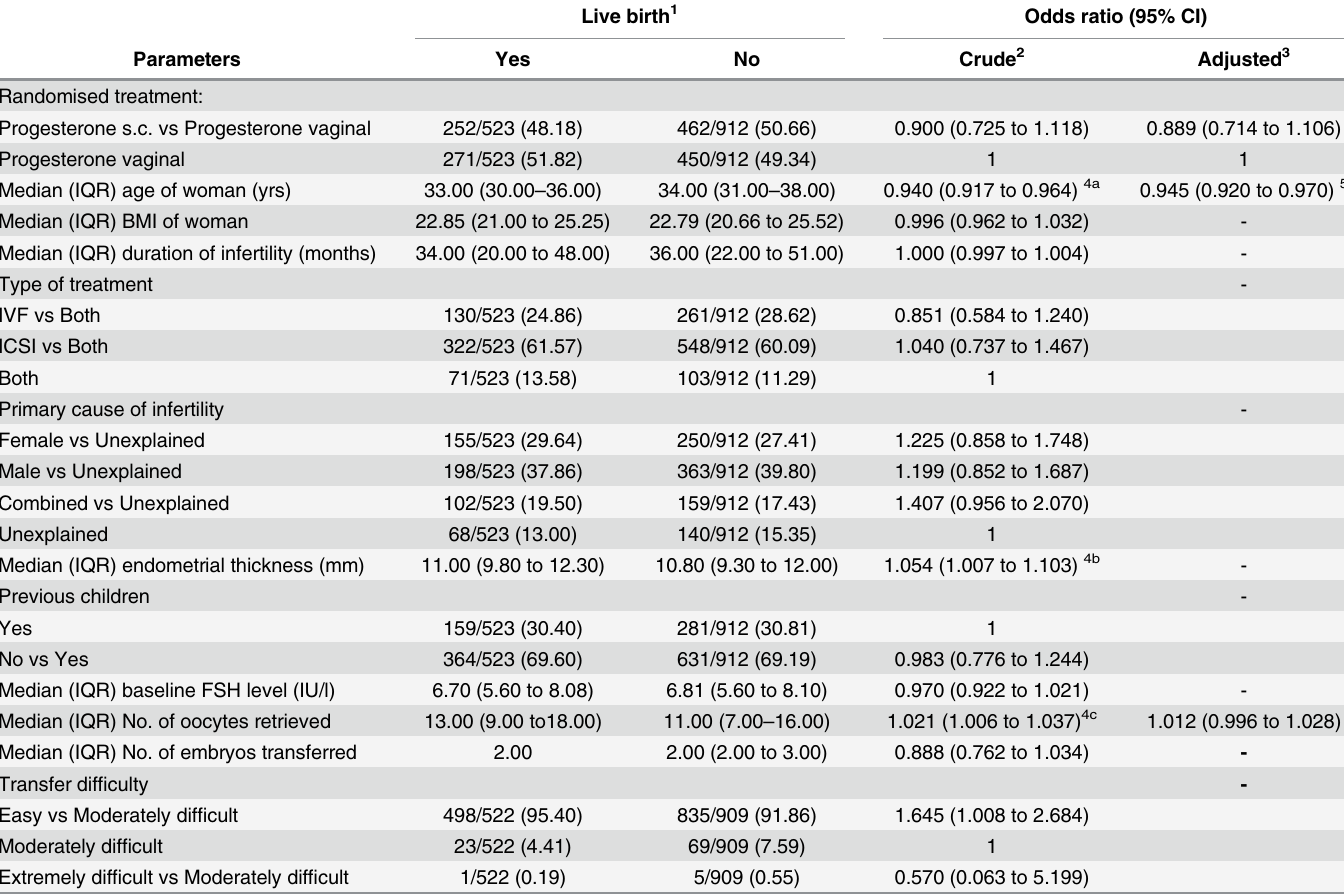
Table 4. In the 07EU/Prg06 trial 5/322 and 8/331 patients in the s.c. progesterone and vaginal progesterone study arm, respectively, were reported as having OHSS of any grade. In the 07USA/ Prg05 trial OHSS was reported in 22/392 and in 18/390 patients in the s.c. progesterone and vagi- nal progesterone study arm, respectively. The pooled odds ratio for s.c. progesterone versus vagi- nal progesterone was 1.04 (95% confidence interval 0.60 to 1.81; P = 0.88; Mantel-Haenszel fixed effects model). The I 2 statistic was 0% (P = 0.32), indicating no heterogeneity between trials. The logistic regression analysis depicted in Table 5 identified young age, PCO and a large num- ber of oocytes retrieved as factors that predispose to OHSS. Compared with younger patients, Table 3. Predictors of live birth after progesterone treatment. Figures are numbers (percentages) unless stated otherwise. Live birth 1 Odds ratio (95% CI)